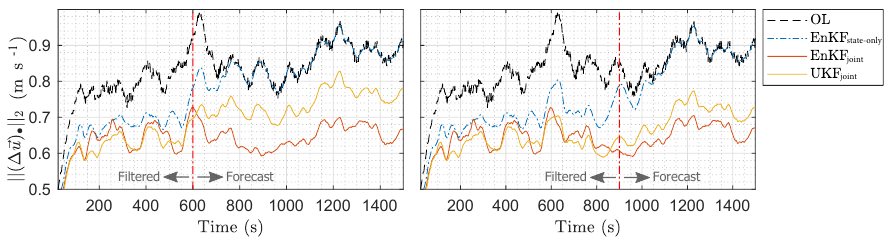
Figure 6. Comparison of forecasting performance for state-only and joint state-parameter ( (cid:96) s ) estimation with the EnKF and UKF, where measurements are available up until the vertical dashed lines, after which the estimation becomes a forecast. Here, the 2-norm of the estima- tion error is plotted along the y axis, with ( (cid:49) u ) (cid:113) = | u (cid:113) − u SOWFA | .